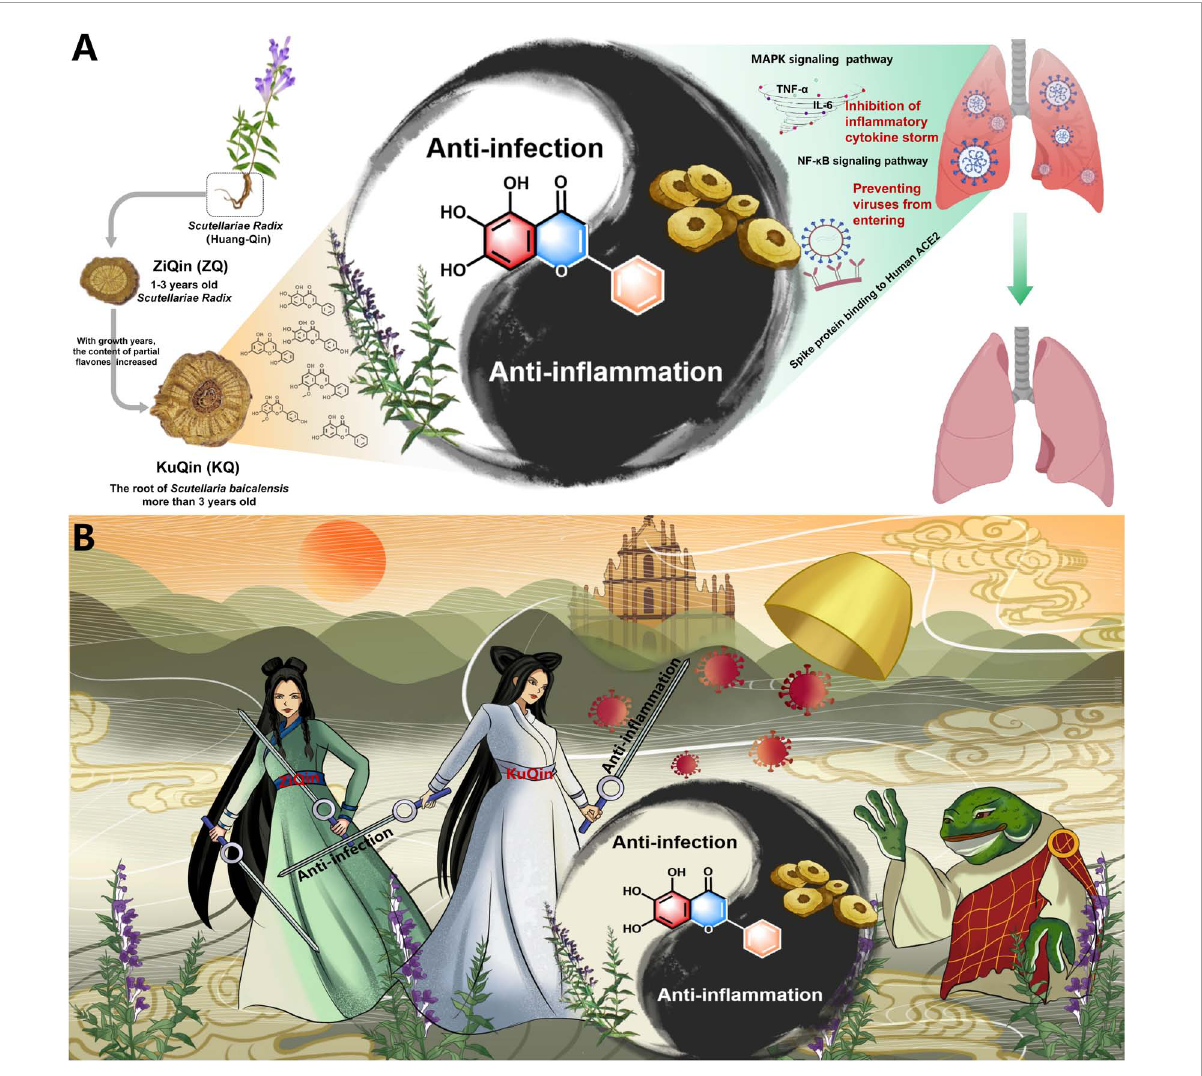
FIGURE11 Summary of the mechanism of Scutellariae radix for the treatment of COVID-19. (A) An academic summary of the mechanism. (B) An artistic summary of the mechanism. In Chinese folklore, a white snake and a green snake become immortal through cultivation and offer generous healing to the poor in the form of beautiful ladies. The white snake’s magic power is stronger than the green snake because white snake has a thousand years of magic power and green snake has only practiced for five hundred years. Their enemy is a toad-turned-demon that has unleashed a plague in the